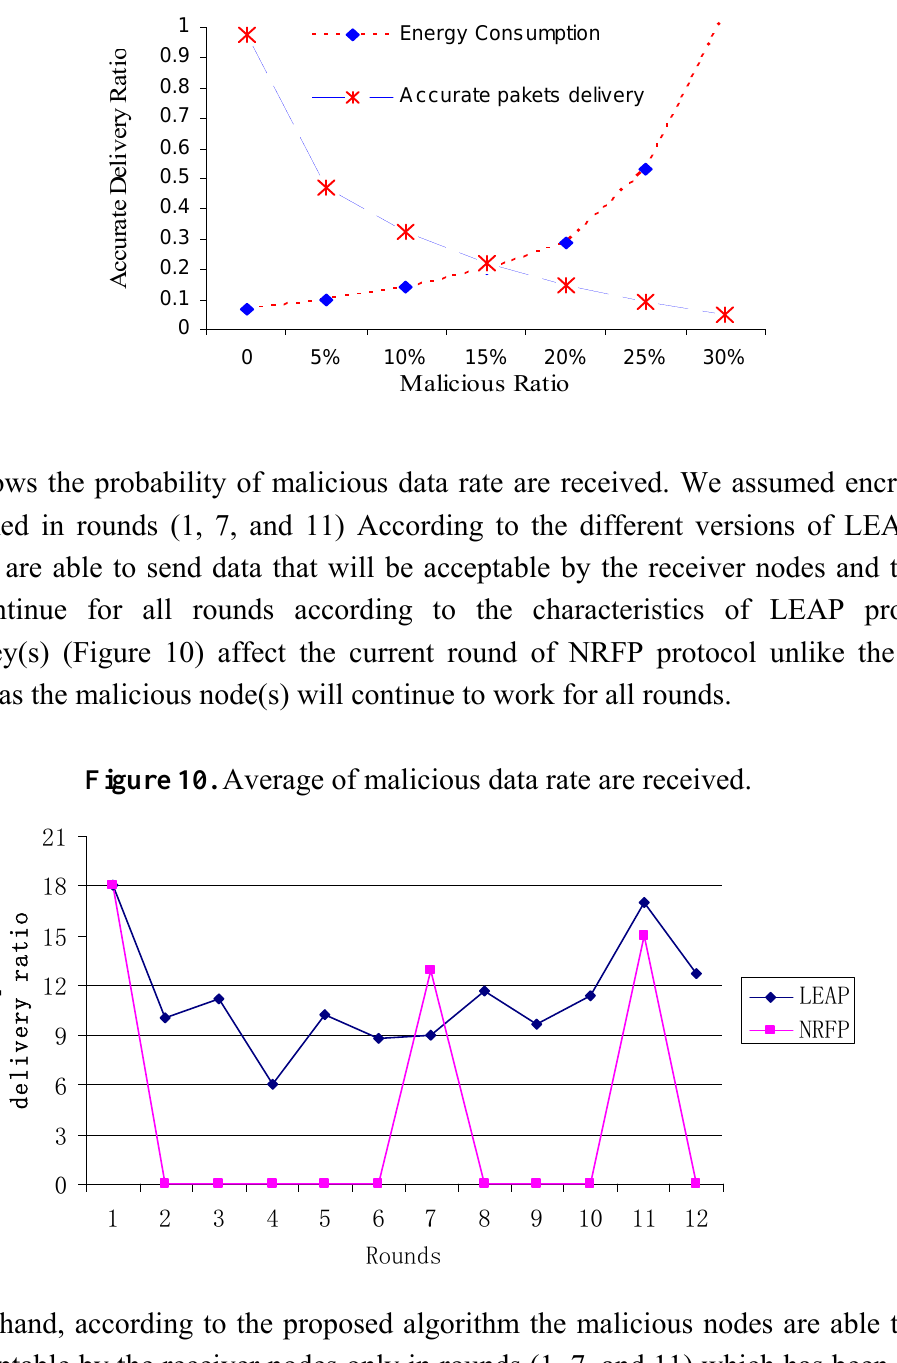
Figure 9 . Black Hole attack run with seven scenarios implemented according to the number of malicious nodes on the network, the energy consumption of each sensor node is as follows [17]: Ea =100 pJ/bit/m2, Ee = 50 nJ/bit and Ec = 5 nJ/bit where consumed for transmitting, receiving and listening respectively. Each sensor needs to send a packet of length R = 400 bits to the cluster head on random time. Cluster head period T is set as 2,000 s and the execution time of task is set as = 0.005 s. The data packet size is 2 KB and the sensing range to 64 meters.